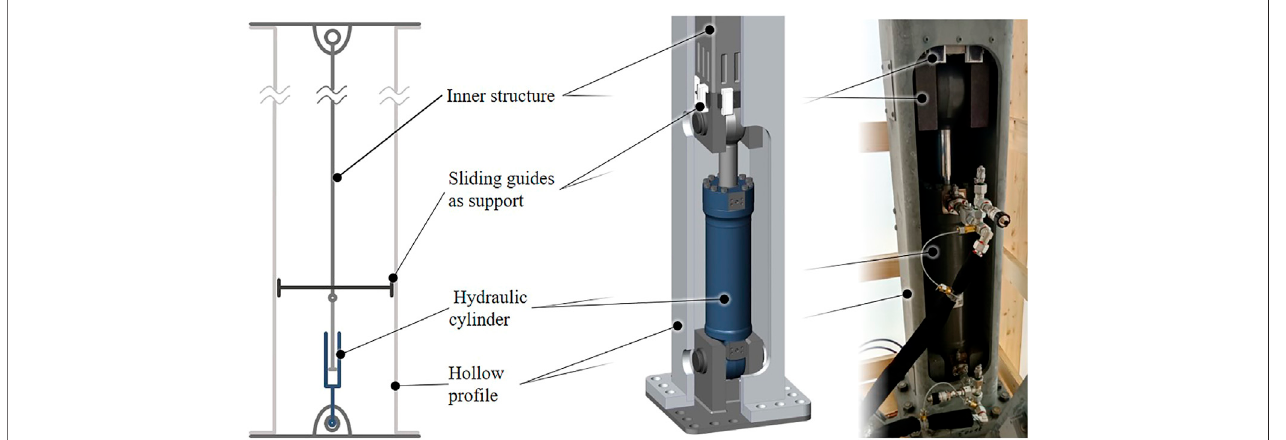
Frontiers in Built Environment |